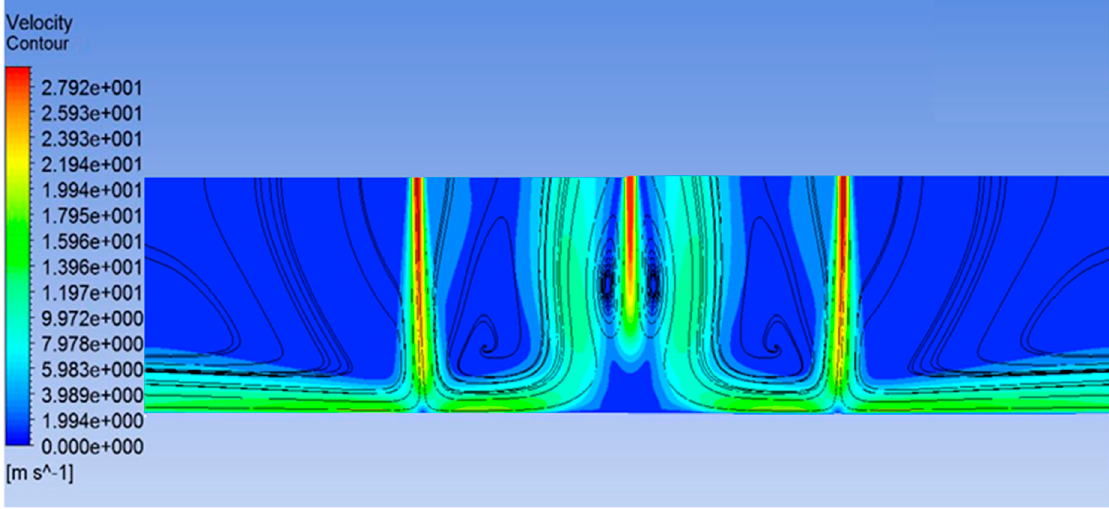
Figure 16. Velocity contours and streamlines of three slot jets configuration with H/B = 16, Re = 5500 and realizable k- ε model.